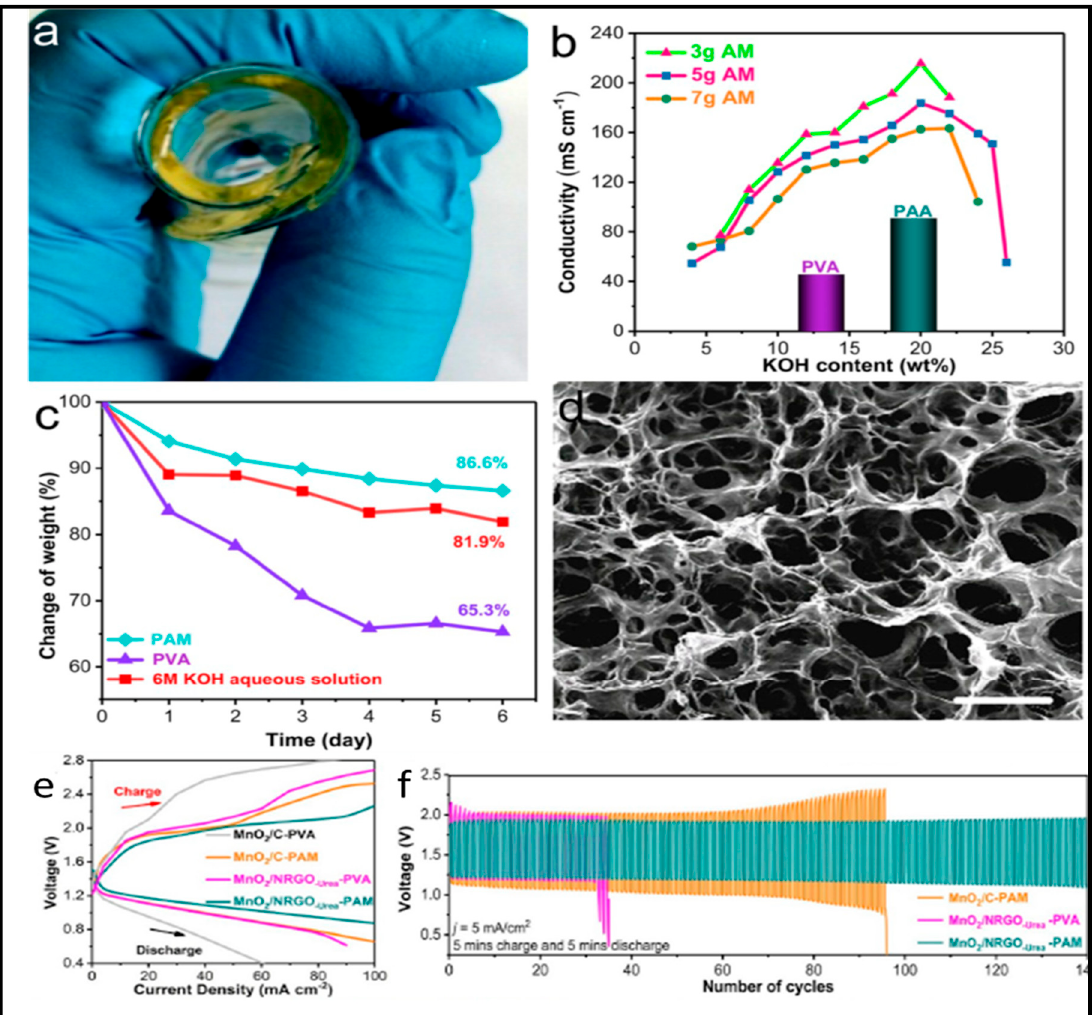
Figure 10. ( a ) A photograph of PAM-based AGE with excellent flexibility. ( b ) Ion conductivities of PAM-based AGEs versus the KOH mass fractions and AM contents. ( c ) Weight changes of PAM, PVA-based AGEs and KOH solution exposed in the ambient air environment. ( d ) SEM image showing the microstructures of PAM-based AGE. Scale bar: 100 mm. ( e ) Charge-discharge polarization curves of flexible ZABs. ( f ) Charge-discharge cycling curves of flexible ZABs. Reproduced with permission